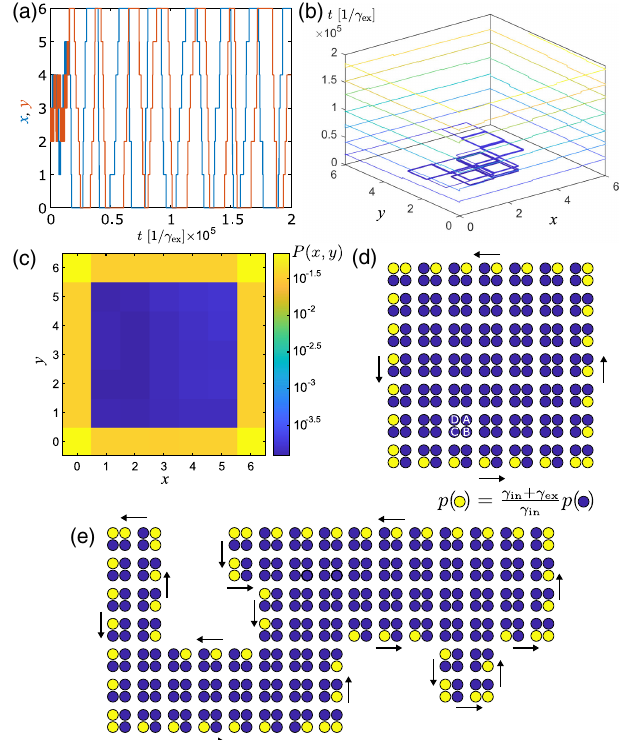
FIG. 2. Emergence of global cycles in the four-state model [Fig. 1(c)]. (a) Simulated stochastic trajectory. Initially, motion is diffusive, until the system encounters the edge at y ¼ 6 , after which it shows persistent oscillations in both x and y . That the FIG. 3. Emergence of global cycles in the three-state model oscillations correspond to counterclockwise edge currents in [Fig. 1(e)]. (a) Simulated stochastic trajectory, showing persistent ð x; y Þ space is clearly seen in panel (b), which depicts the same oscillations in both x and y . (b) Same trajectory, but in two trajectory, but in two dimensions (color represents time). (c) Prob- dimensions, clearly showing counterclockwise cycles (color ability distribution in ð x; y Þ space, obtained from simulations, and represents time). (c) Probability distribution in ð x; y Þ space, (d) the steady-state probability distribution in full configuration obtained from simulations, and (d) the steady-state probability space, obtained from a direct solution of the master equation, both distribution in full configuration space, obtained from a direct showing strong accumulation of probability at the edges. The four solution of the master equation, both showing strong accumu- arrows in panel (d) indicate the direction of the edge currents. lation of probability at the edges. The three arrows in panel (e) Edge currents and the resulting cycles, which are robust with (d) indicate the direction of the edge currents. Parameters used are 10 − 3 γ respect to the shape of the boundaries. The parameters used are as as follows: in panels (a) – (c), γ ; in (a) – (d), system in ¼ ex 10 − 3 γ follows: in panels (a) – (c), γ ; in (a) – (d), system size size N x ¼ 6 and y ≤ x ; in (c), 10 7 steps starting from a random in ¼ ex N 6 ; in (c), 10 7 steps starting from a random initial N initial state. See also Fig. 9 in Appendix A and Movie 2 in the x ¼ y ¼ Supplemental Material state. See also Movie 1 in the Supplemental Material [49].